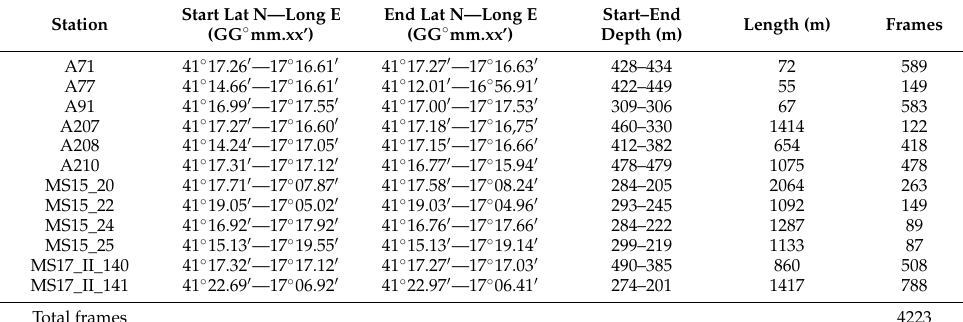
Table 1. Summary of the ROV metadata.